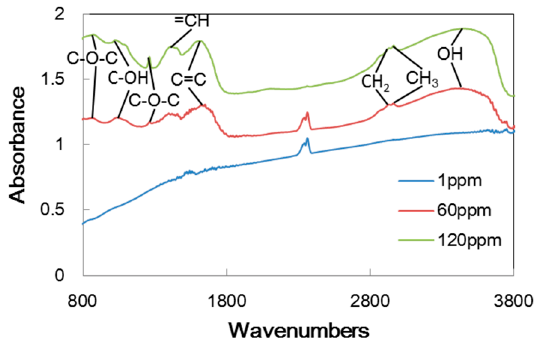
Figure 7. FT-IR spectrum of aluminum surface slid against a-C:H DLC in argon.